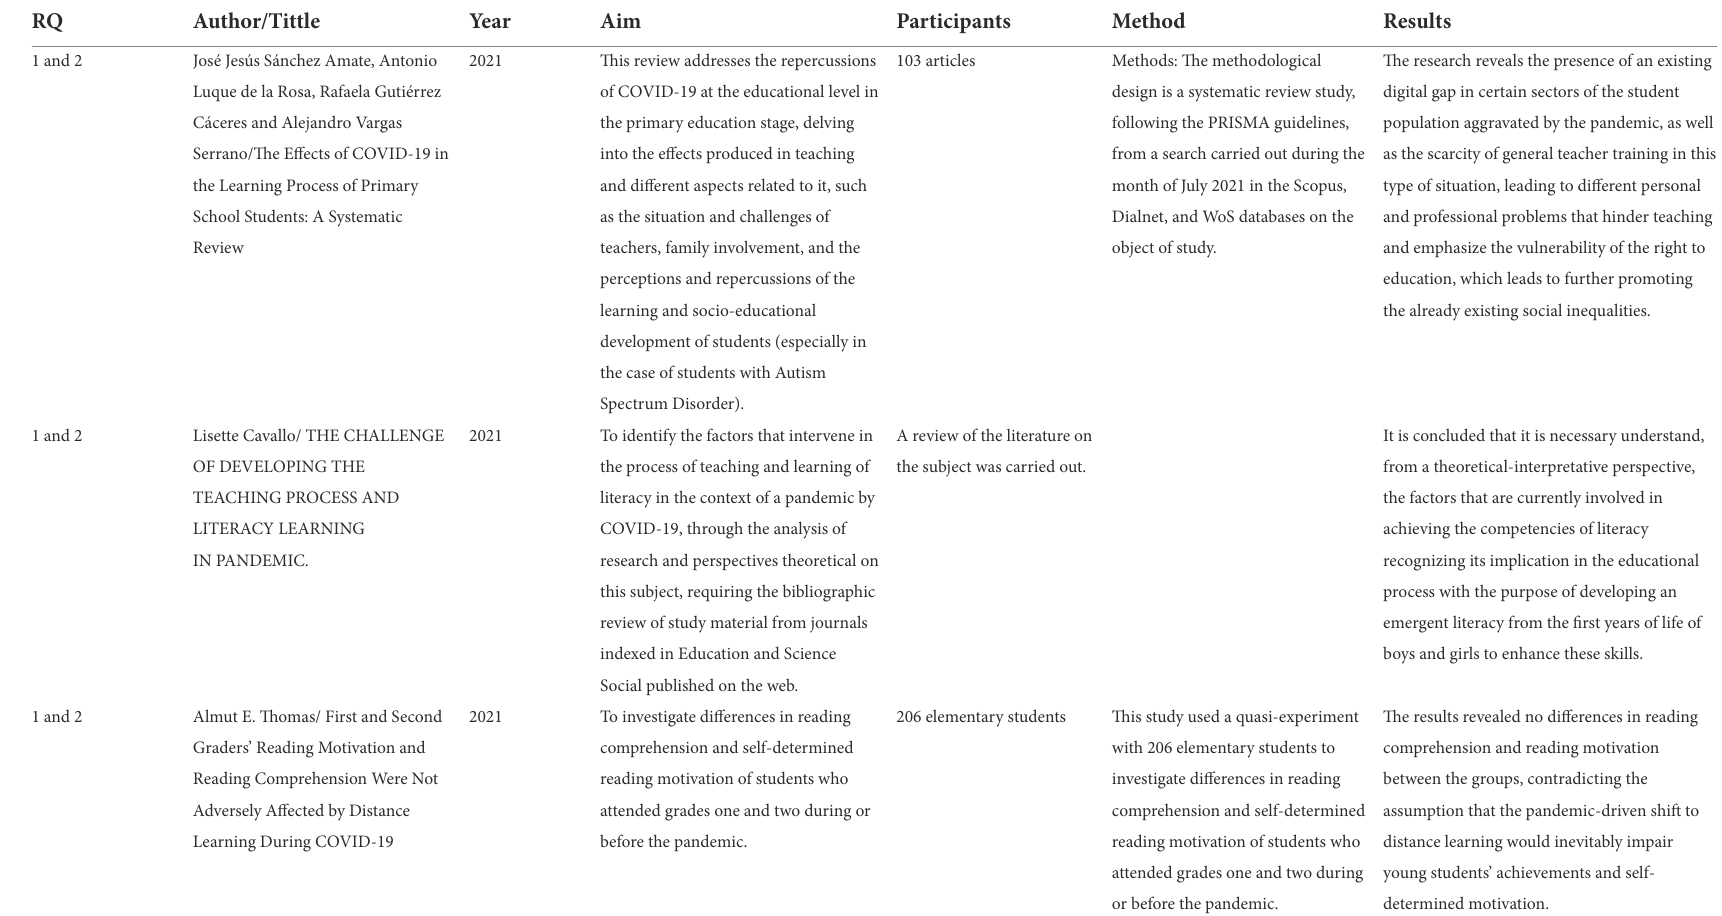
TABLE 1 Description of the articles